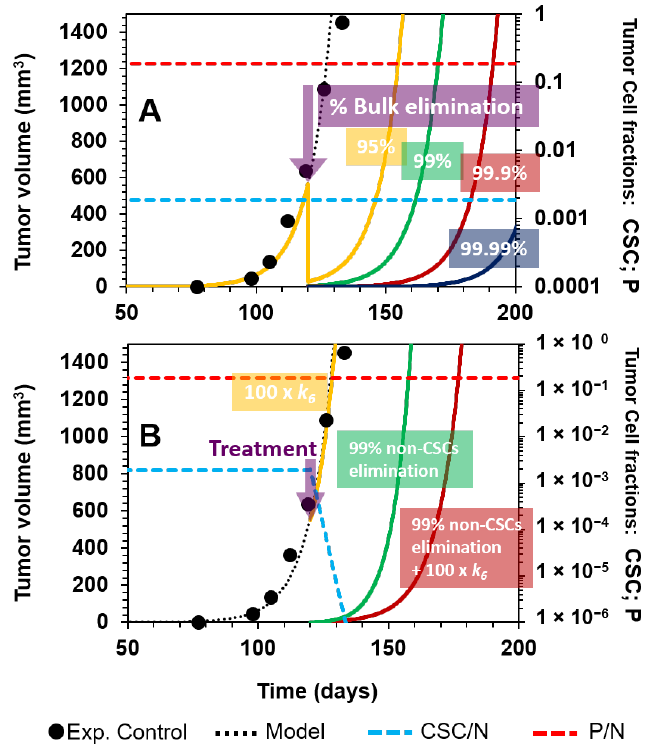
Figure 4. Nonselective treatment and directed therapy against CSCs. ( A ) Progression of a tumor without intervention is depicted from day 0 to 120 (black points, experimental data; dotted black curve, model fitting). At day 120 (purple arrow), the bulk of the tumor, CSCs, and P and D cells, is nonselectively eradicated: 95% (yellow line), 99% (green line), 99.9% (dark red line), and 99.99% (dark blue line). The CSC fraction (dashed blue line) and P fraction (dashed red line) remain unaltered for all nonselective treatments. ( B ) Selective targeting of CSCs at day 120: 100-fold enhancement of k 6 does not affect tumor progression (yellow line), although the fraction of CSCs diminishes (dashed blue line). When 99% of all cells except CSCs are eradicated at day 120 (green line), in addition to a 100-fold enhancement of k 6 , there is a better response (dark red line) than using either treatment alone.